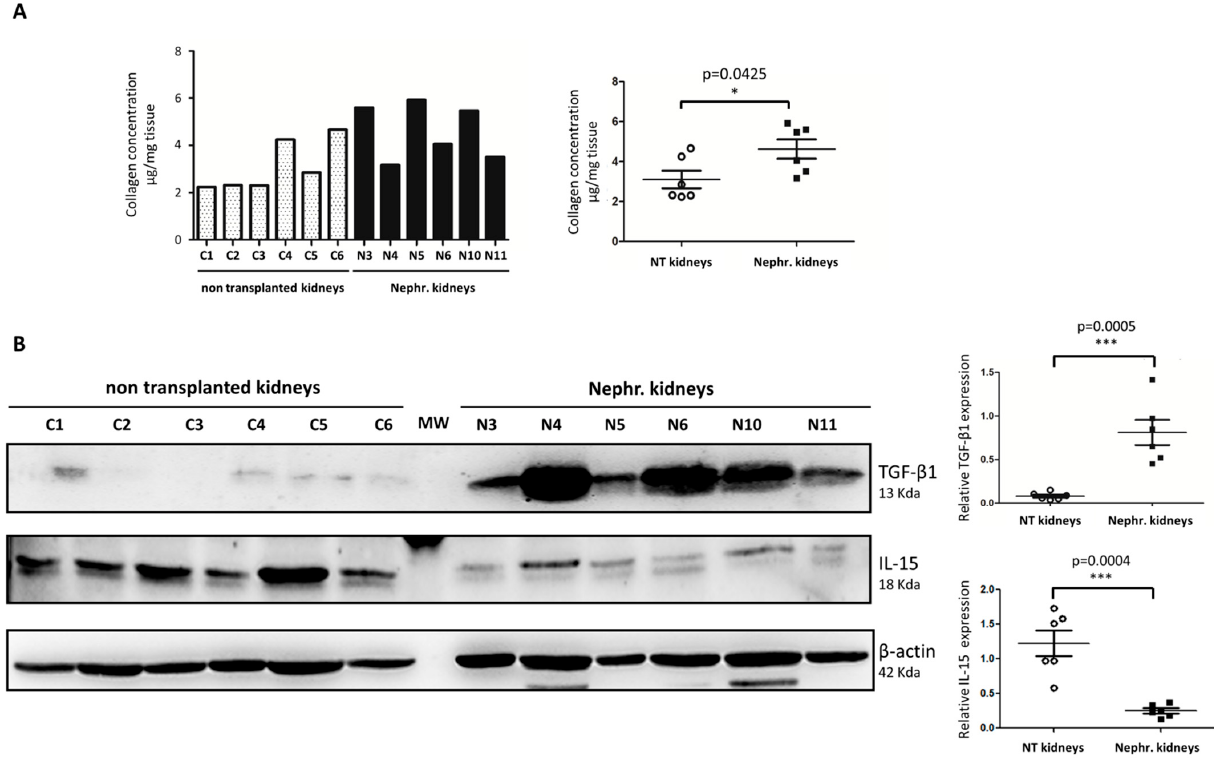
Figure 1. IL-15 expression was reduced in nephrectomized human kidney transplants compared with non-fibrotic “non-transplanted kidneys”. ( A ) Collagen content by hydroxyproline (HYP) assay in well-functioning transplants non-transplanted kidneys (NT kidneys) and nephrectomized allografts (Nephr. kidneys) from patients with renal rejection (4.6 ± 0.4 µg Hyp/mg tissue in Neph. kidneys in comparison to NT kidneys (3.1 ± 0.4 µg Hyp/mg tissue, * p < 0.05). ( B ) IL-15 and TGF- β expression were quantified by Western blot. Left, Representative Western blots of one experiment are shown. Right, Bar charts represent IL-15 and TGF- β expression normalized to β -actin. IL-15 (*** p < 0.001), TGF- β (*** p < 0.001), n = 6. Values are means ±